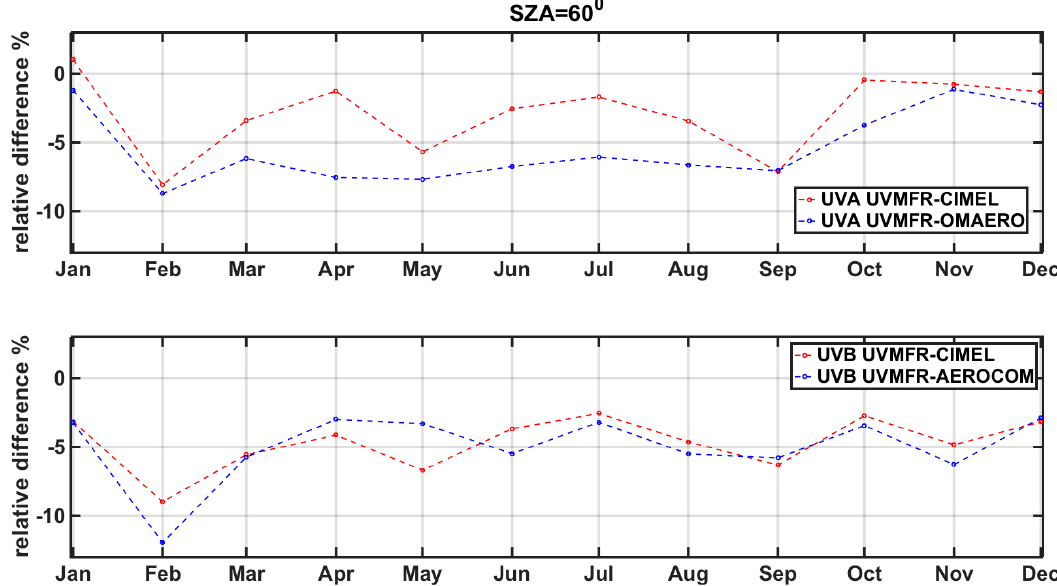
Figure 5. Mean Monthly Relative difference in UVA ( upper plot ) and UVB ( lower plot ), calculated with different SSA input and using time series of UVMFR SSA as reference.